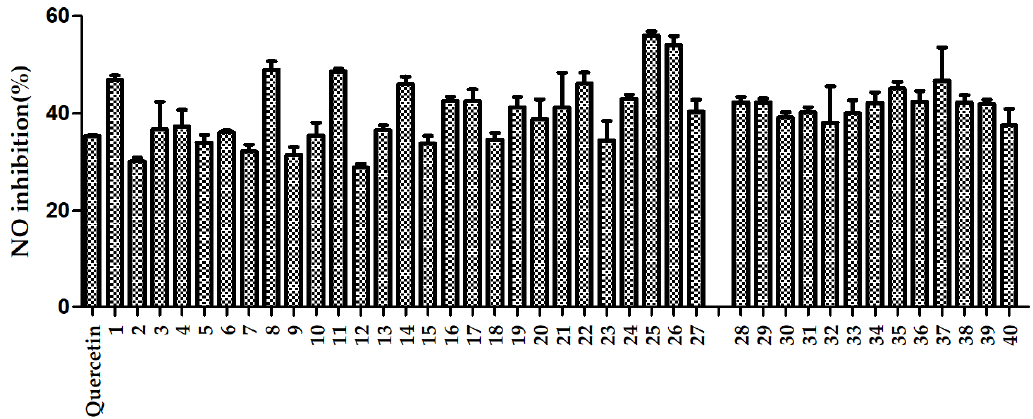
Figure 4. NO inhibition rates of extracts of RAS from non-geoherbs (1–27) and geoherbs (28–40).